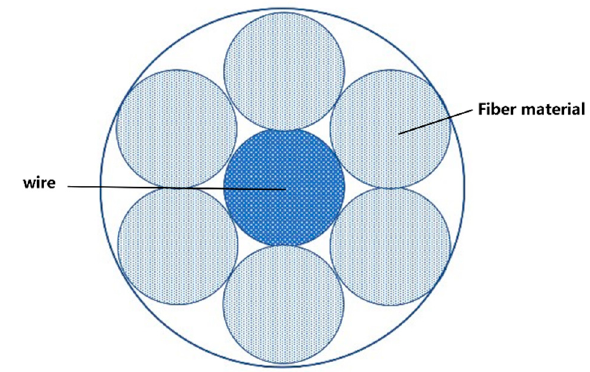
Figure 3. Cross-section of towing rope.